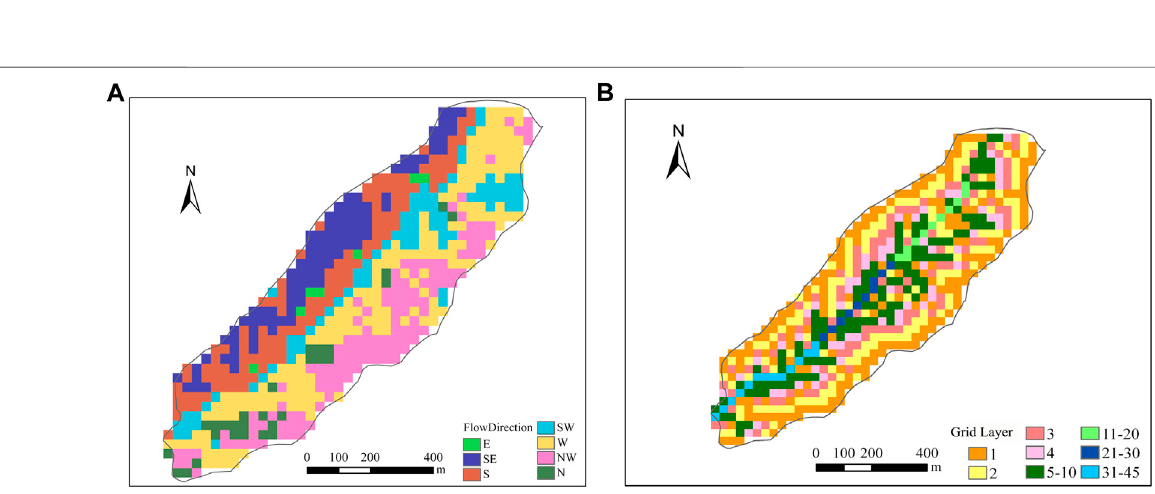
Frontiers in Environmental Science |